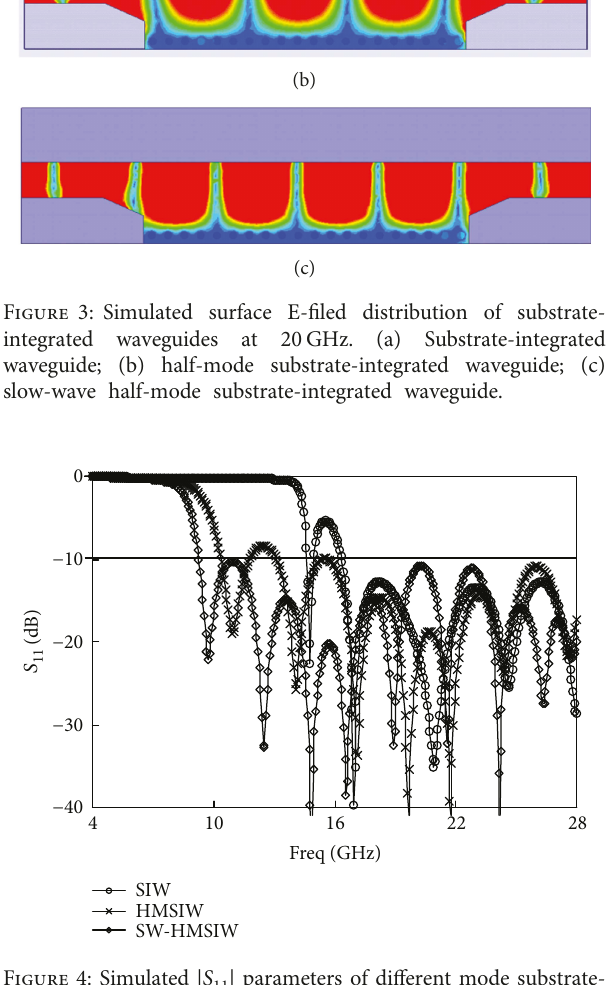
| parameters of di ff erent mode substrate- 11